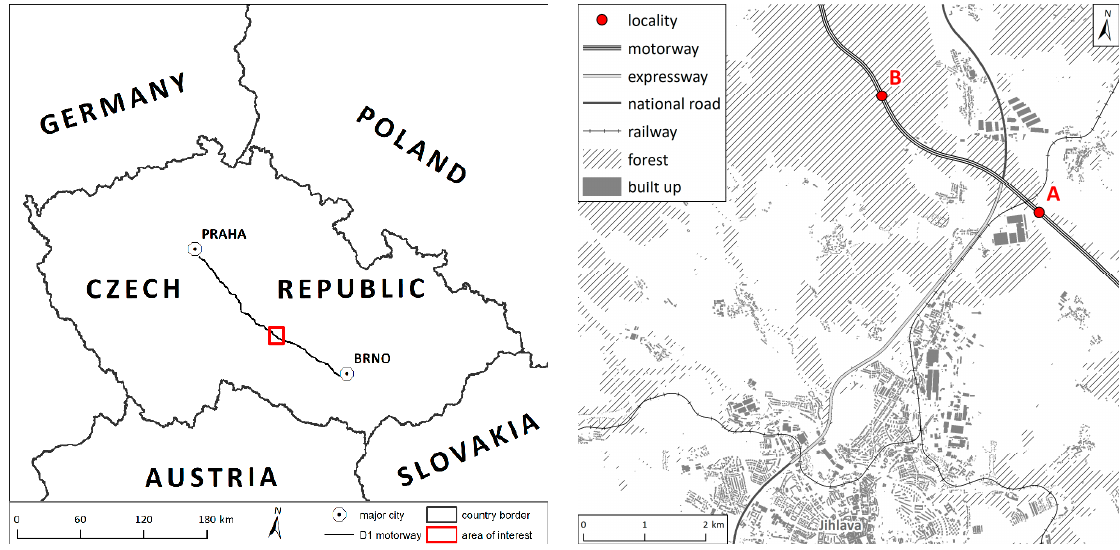
Figure 1. The Jihlava region with marked Sites A and B.